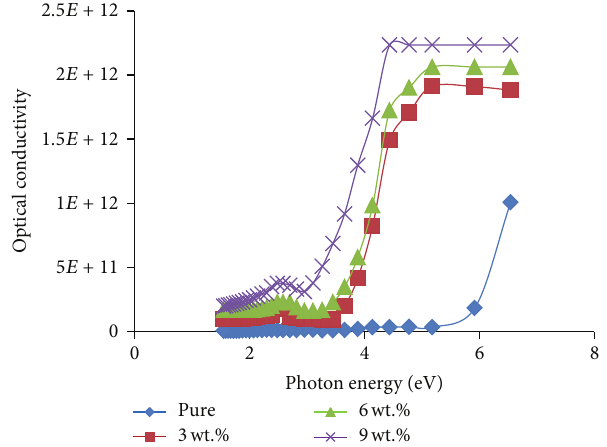
Figure 15: The optical conductivity PVAc/0, PVAc/3, PVAc/6, and PVAc/9 wt.% of [Co(NH 3 ) 5 Cl]Cl 2 composites films as a function of photon